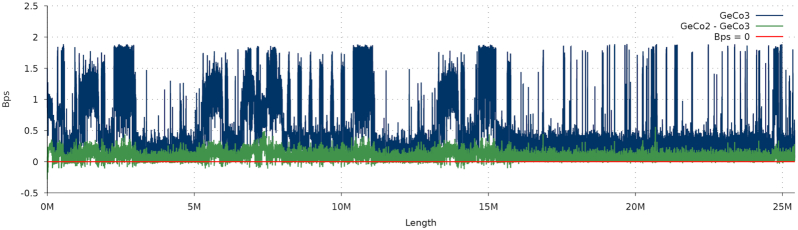
Complexity profile using the smoothed number of bits per symbol (Bps) of GeCo2 subtracted by GeCo3 Bps. The Bps were obtained by referential compression of PT_Y (Chromosome Y from Pan troglodytes) with the corresponding Homo sapiens chromosome, with the same parameters as in Table 4. Regions where the line rises above zero indicate that GeCo3 compresses more than GeCo2.